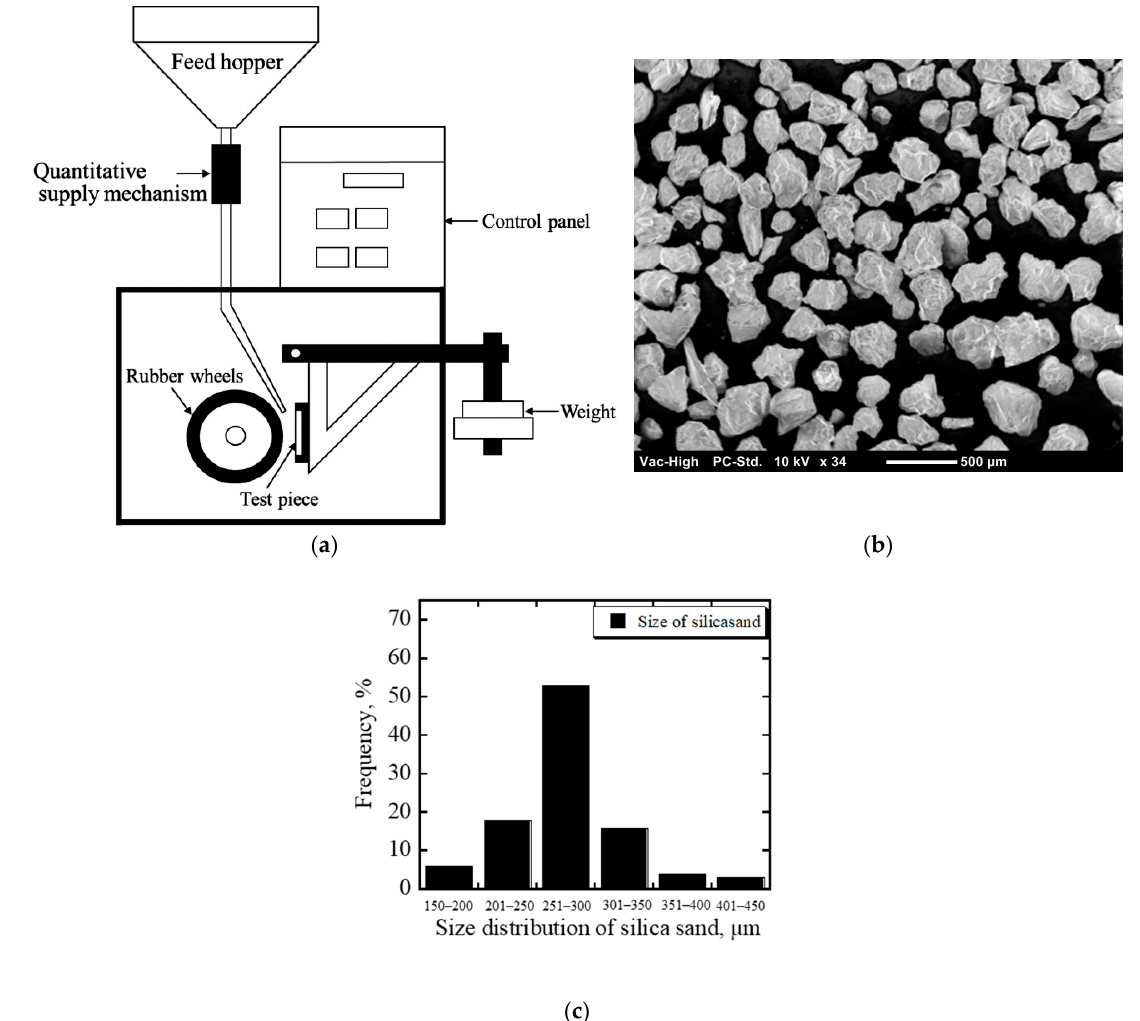
Figure 2. ( a ) Schematic drawing of the abrasion machine test; ( b ) image of the abrasive particle; ( c ) abrasive particle distribution size.